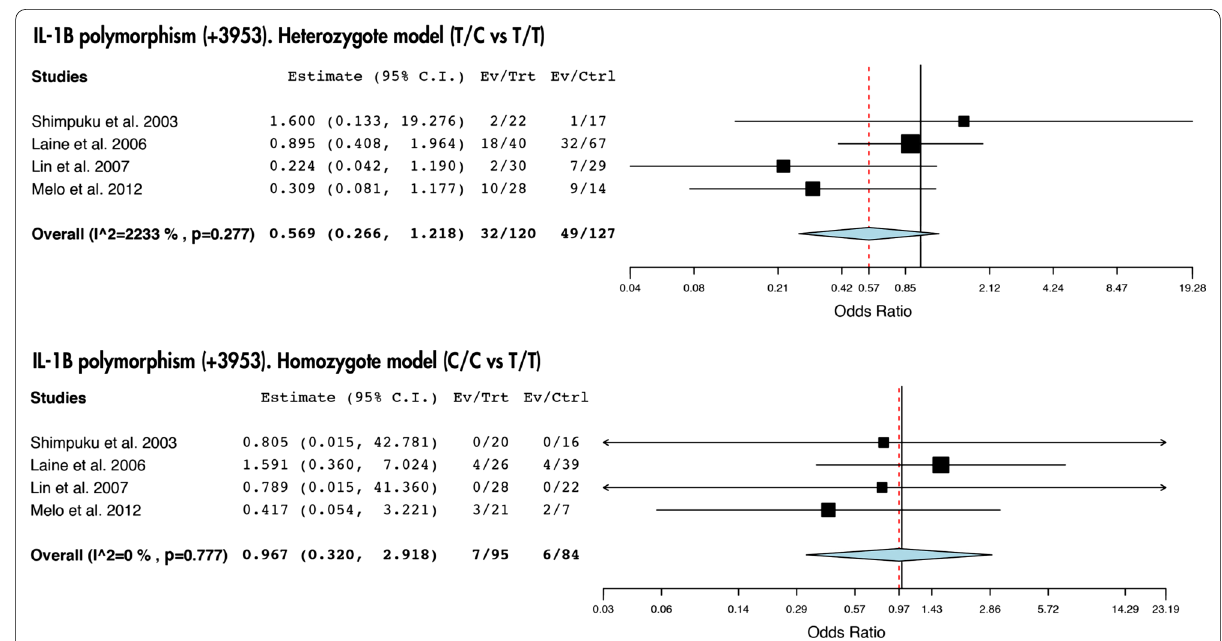
Fig. 2 Association between IL‑1β ( 3953) polymorphism and peri‑implantitis in the heterozygote and homozygote +